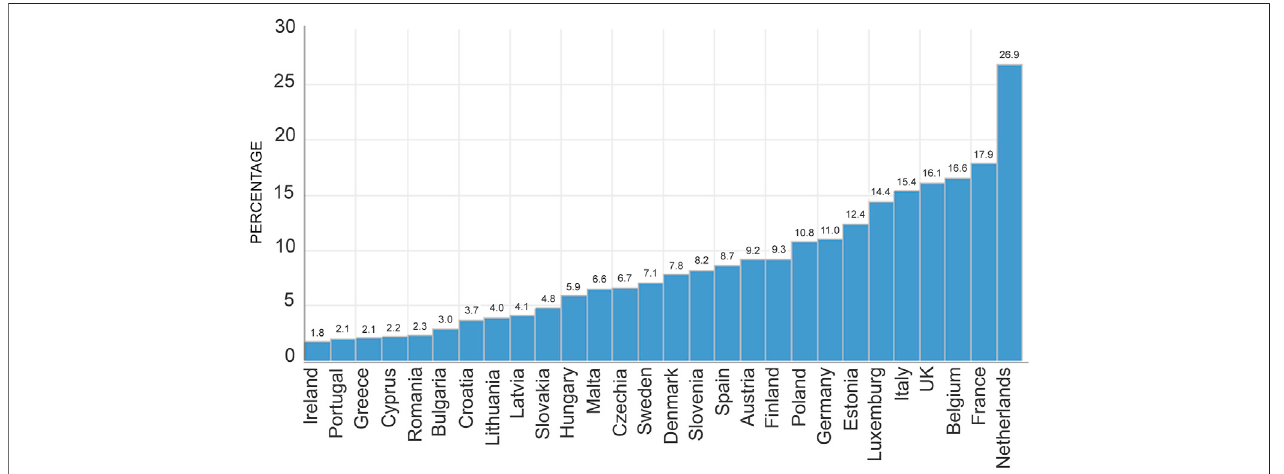
FIGURE 1 | Mean of circular material use in EU, percentage (2010 – 2017)/Source: own calculation with Eurostat data.